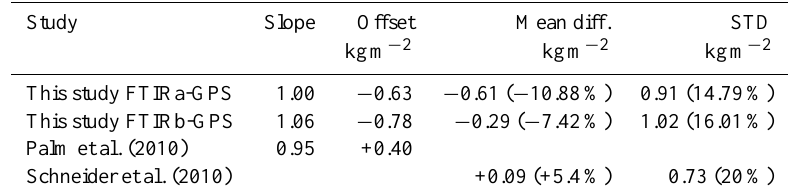
Table 7. Literature results for FTIR versus GPS. Parameters are defined as in Table 6.